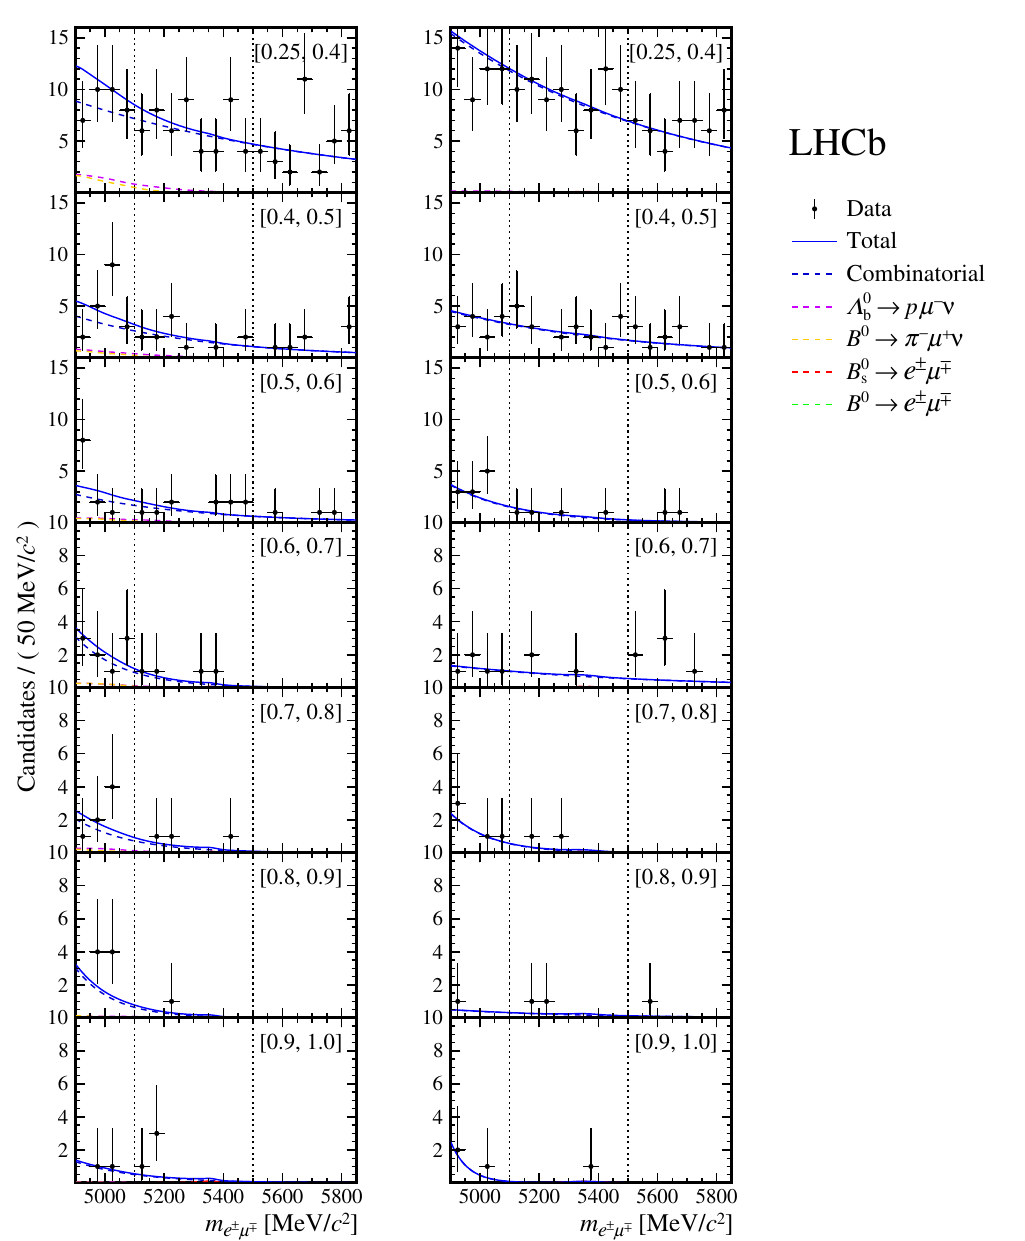
Figure 4 . Distributions of the invariant mass of the B 0 into bins of BDT response and two bremsstrahlung categories (left) without and (right) with bremsstrahlung photons recovered. The result of the (cid:12)t is overlaid and the di(cid:11)erent components are detailed. The edges of the range that was examined only after (cid:12)nalising the selection and (cid:12)t procedure are delimited by gray dashed vertical lines. This region includes 90% of the potential signal candidates. Given the result obtained from the (cid:12)t, the B 0 ! e (cid:6) (cid:22) (cid:7) component is not visible in the